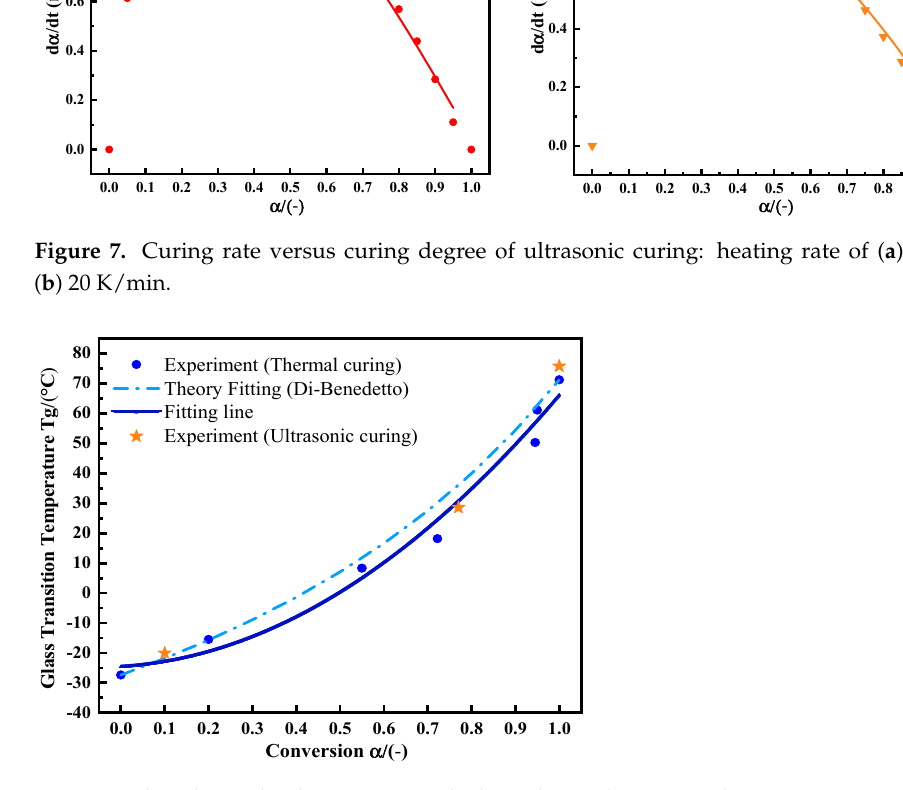
Figure 8. The relationship between T g and α by utilizing the Di-Benedetto equation.